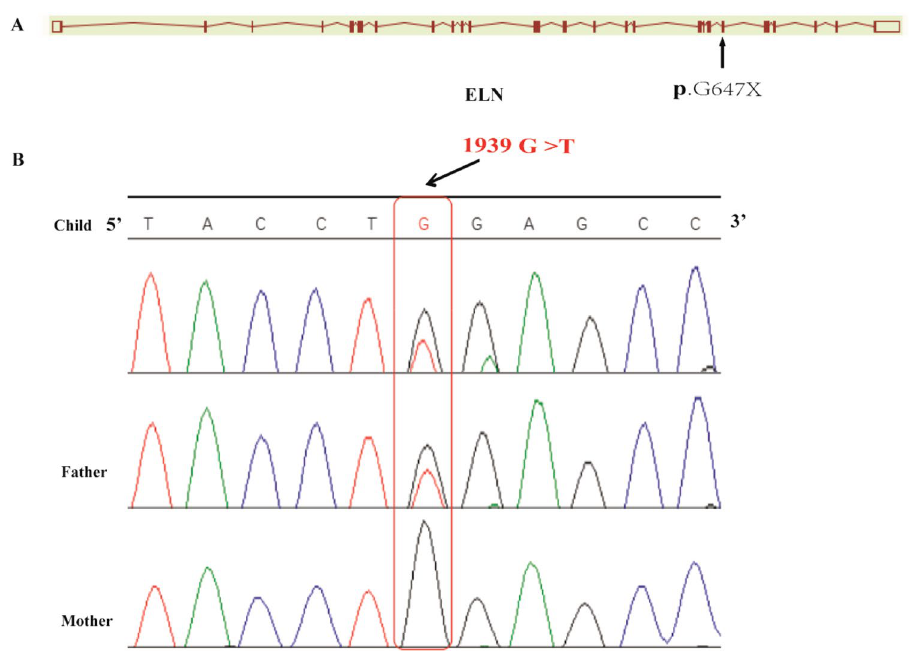
Figure 3. The ELN mutation site and its conservation. ( A ) Human ELN gene maps to chromosome 7q11.23 and contains 34 exomes. The base pair mutation site is c.1939G>T, which is located on the exome 27 of ELN . ( B ) The proband and her father were confirmed to be heterozygous carriers of 1939G>T hybridization, and her mother was homozygous negative for this mutation, as shown by Sanger